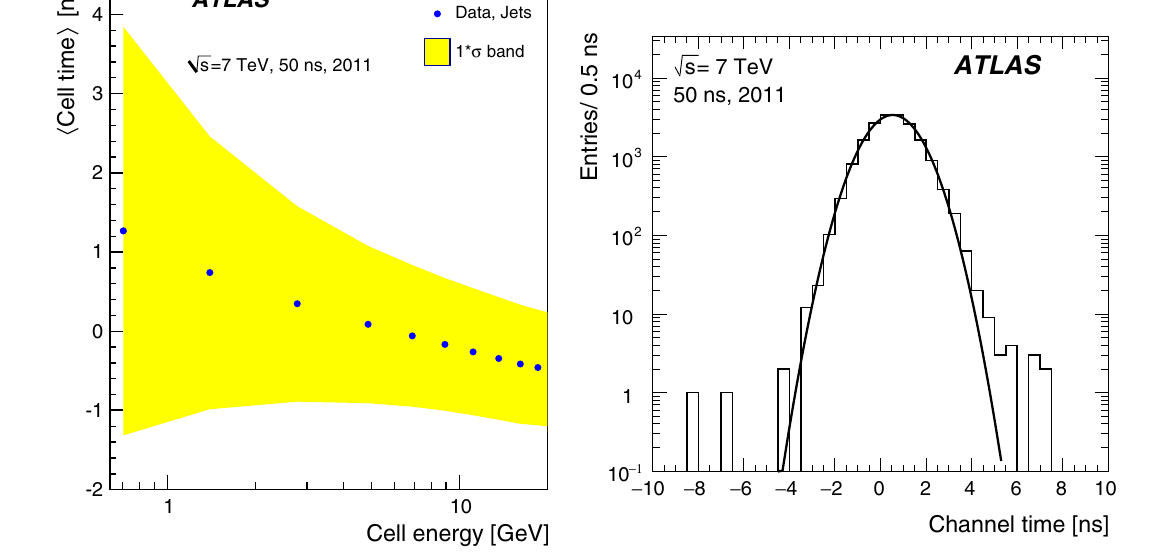
component of hadronic showers [26,27]. Right: example of the channel reconstructed time in jet events in 2011 data, with the channel energy between 2 and 4GeV. The solid line represents the Gaussian fit to the